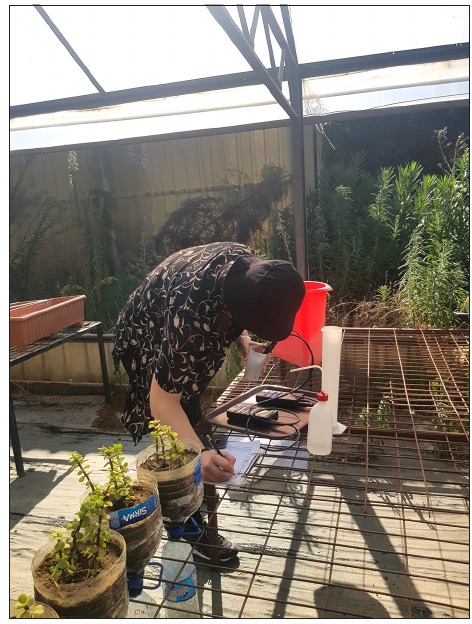
Figure 6. EC and pH measurements of drainage